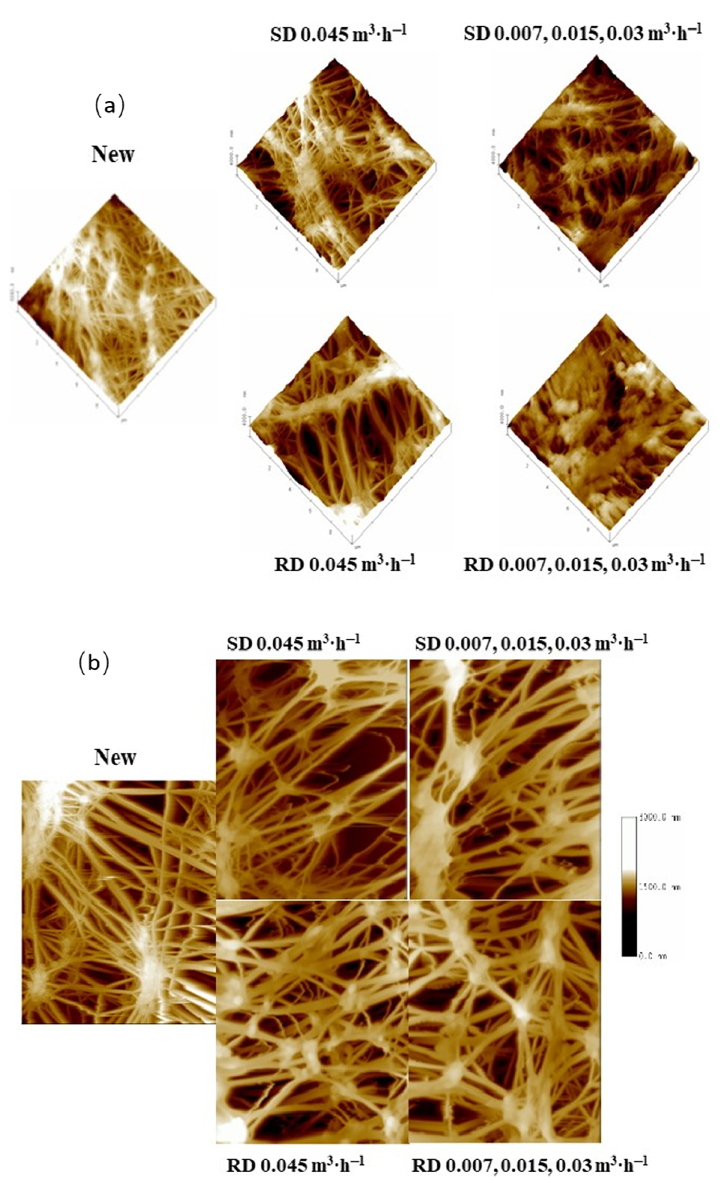
Figure 6. AFM 3D topographic images of the active layer ( a ) and 2D topographic images of the support layer ( b ) for the PTFE 0.22 µm membrane under different conditions (scanned area 10 µm × 10 µm). Legends correspond to the digestate, SD or RD, treated and the recirculation flow rates used successively.